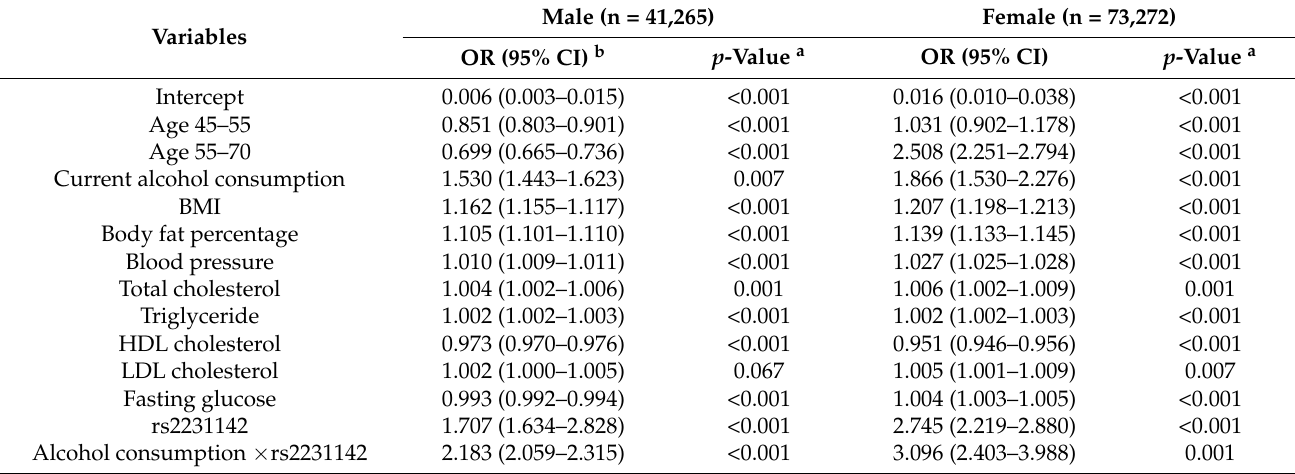
Table 3. Interaction between alcohol consumption and ABCG2